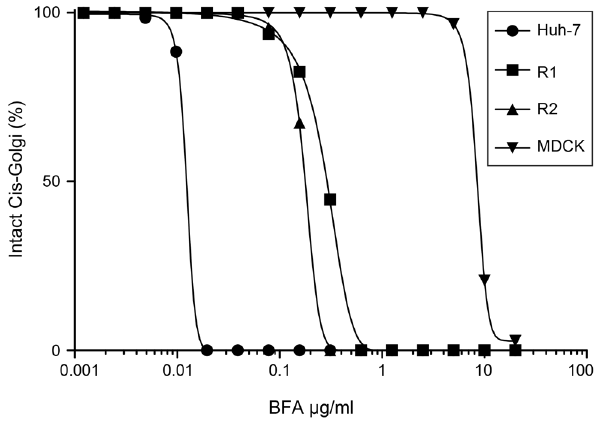
Figure 7. BFA sensitivity of the cis-Golgi of Huh-7, R1, R2 and MDCK cells. Cells were treated for 30 minutes with increasing concentrations of BFA, fixed and processed for the immunofluorescent detection of GM130. For each condition, approximately 100 cells were scored for their cis-Golgi morphology, as either intact or scattered. For each cell line, the percentages of cells with intact cis-Golgi morphology were plotted against BFA concentrations.